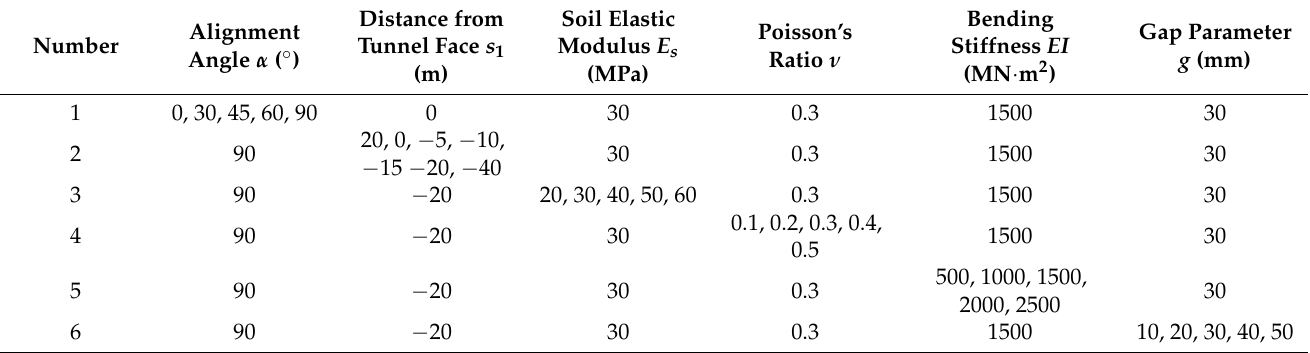
Table 3. Parameters used for analysis.